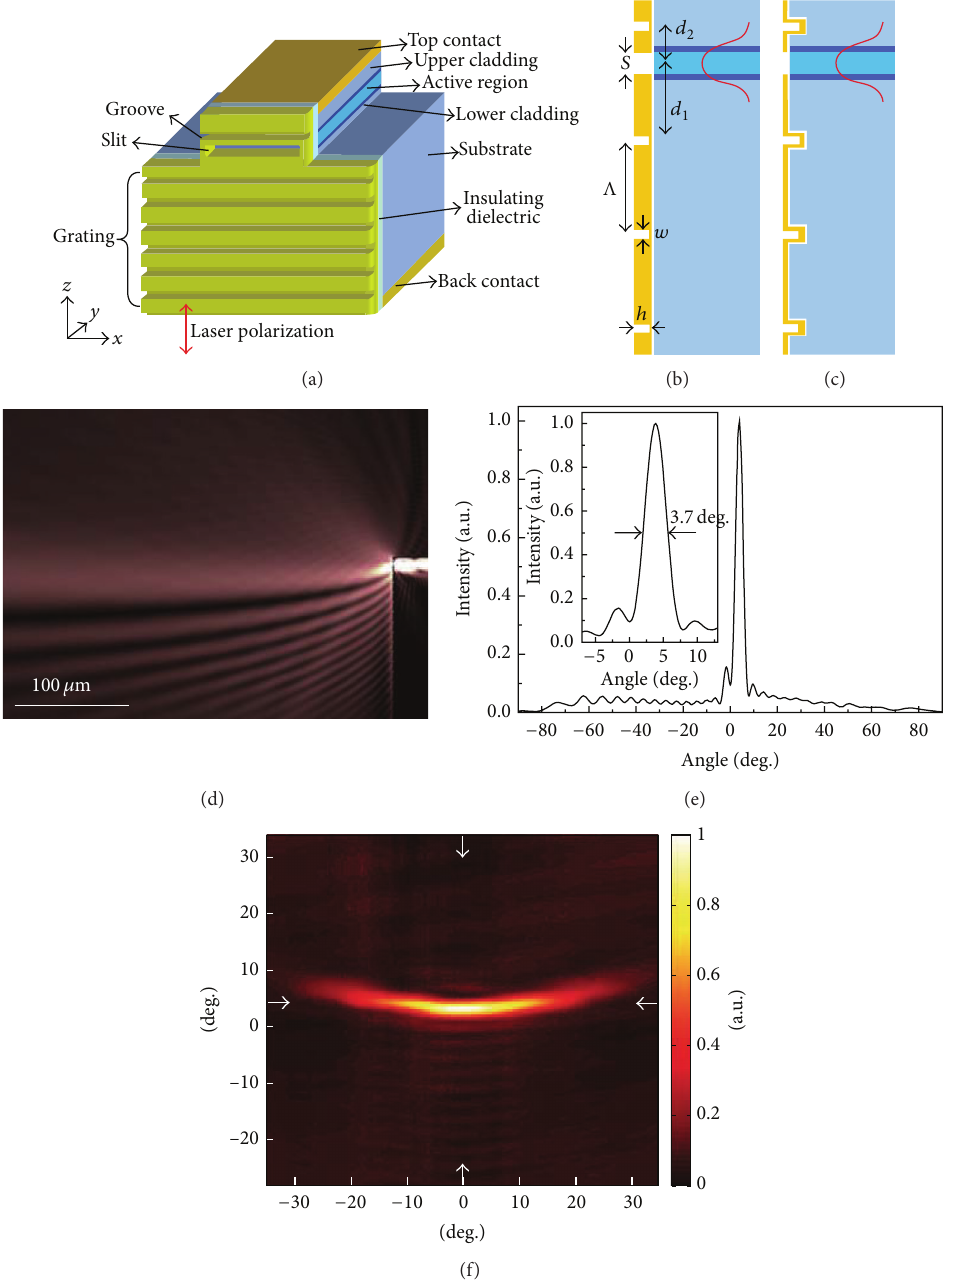
Figure 29: (a) Schematic of the small-divergence laser, which comprises a QCL and a metallic slit-grating structure defined on its facet. (b, c) Cross sections of the two device designs. (d) 2D simulation of the intensity distribution of a small-divergence QCL of the second design lasing at 𝜆 = 9.9 𝜇 m. (e) Calculated far-field intensity distribution of the device shown in (d); inset: enlarged view of the central lobe. (f) Measured 2D far-field intensity of device B patterned with the slit-grating structure. Figures are reproduced from